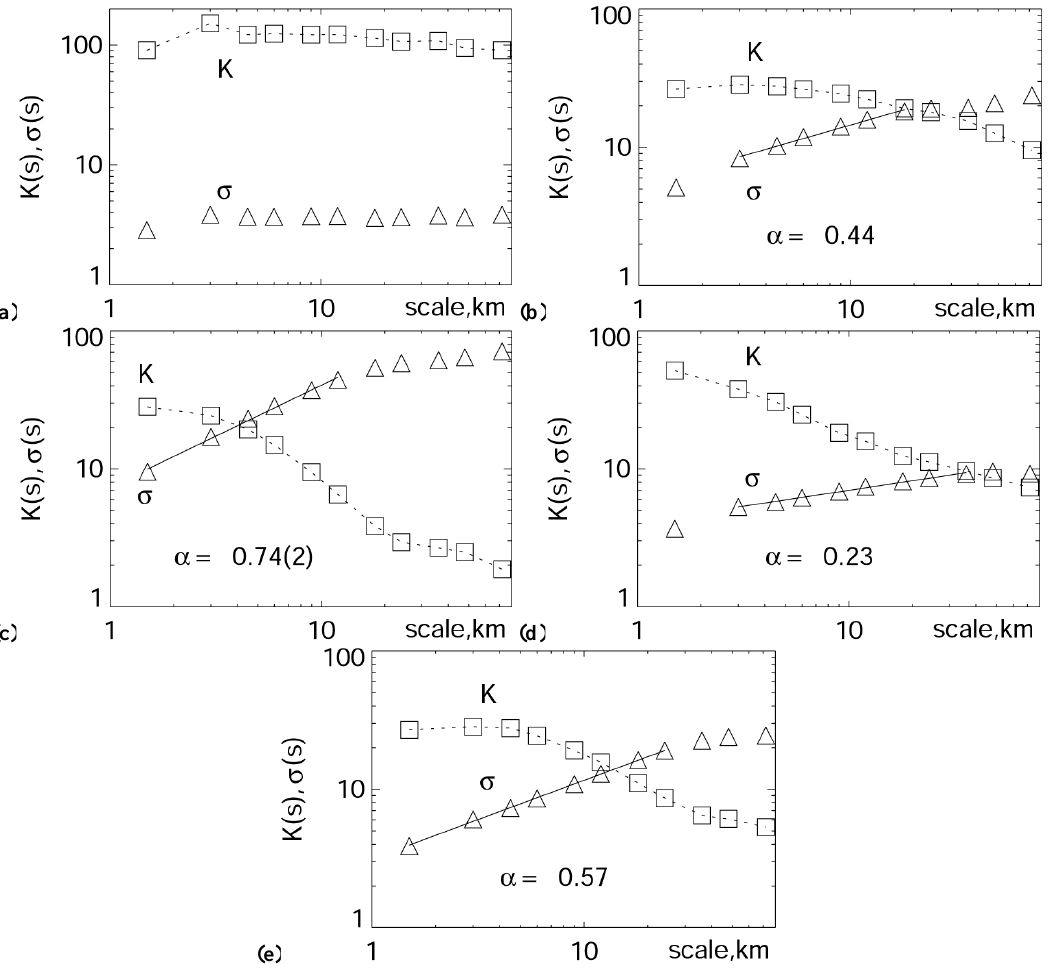
Fig. 5. Scale dependence of the standard deviation σ and kurtosis K for PDFs presented in Fig. 3. The region of the least-squares power-law approximation in the σ plot is shown by solid line, α is a power index of the approximation. Uncertainty of the α values is less than last decimal unit or they are presented in